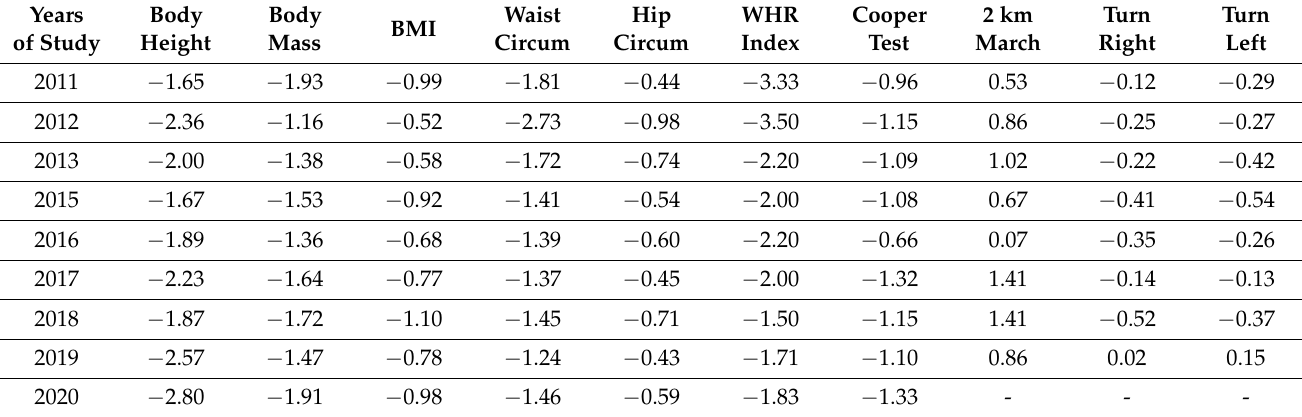
Table 8. Calculated Mollison indicators assessing dimorphic differences in motor and anthropometric